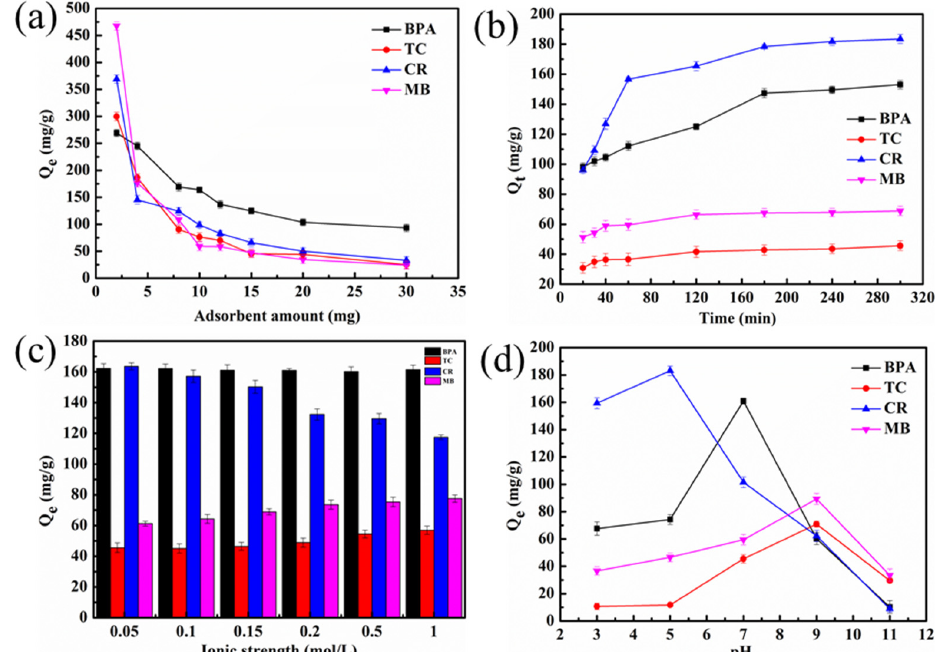
Figure 4. ( a ) influence of adsorbent amounts on BPA, TC, CR, and MB; ( b ) influence of time on BPA, TC, CR, and MB; and ( c ) influence of ionic strength on BPA, TC, CR, and MB; ( d ) Influence of pH on BPA, TC, CR, and MB. Those error bars are standard deviations. The materials were inde- pendently prepared to repeat the same experiment at least three times to ensure the accuracy of the